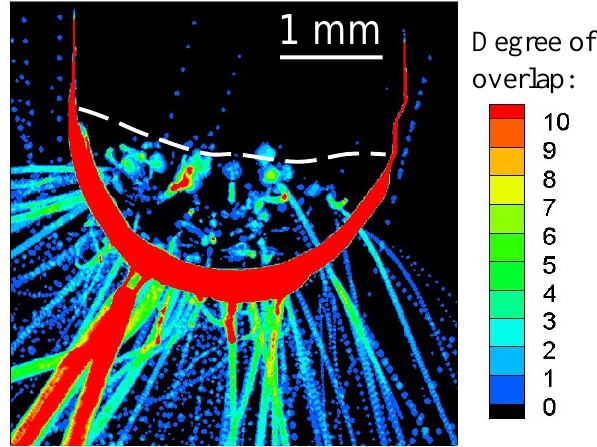
Figure 7. Trajectory of the droplet’s ejection during 10 AC cycles.